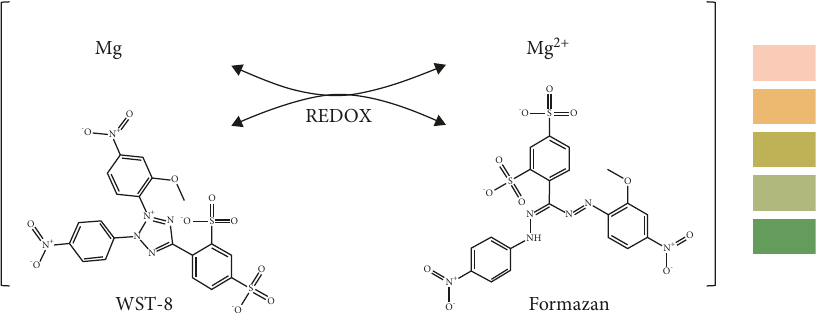
Figure 1: Symbolic representation of the main chemical reaction with the visible reagent color changes during the f -test [34–38].